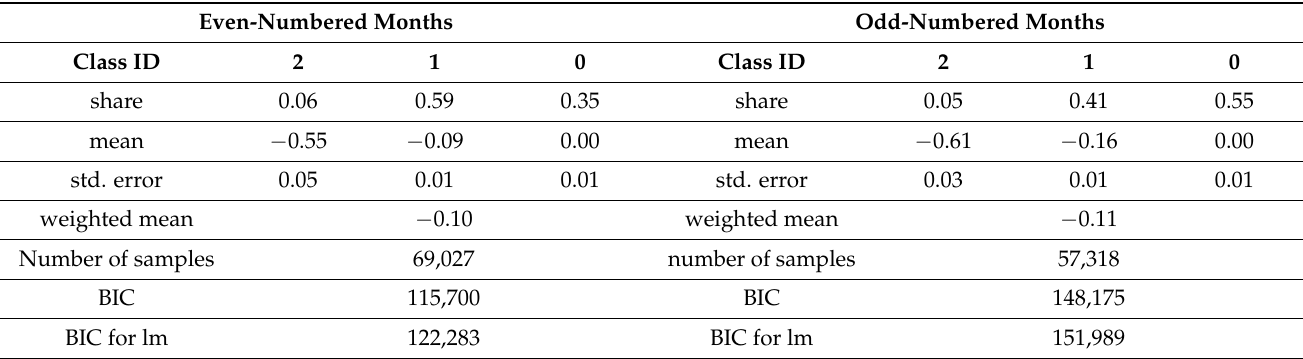
Figure 4. Relationship between BIC and number of classes. Table 3. Estimated results of latent class